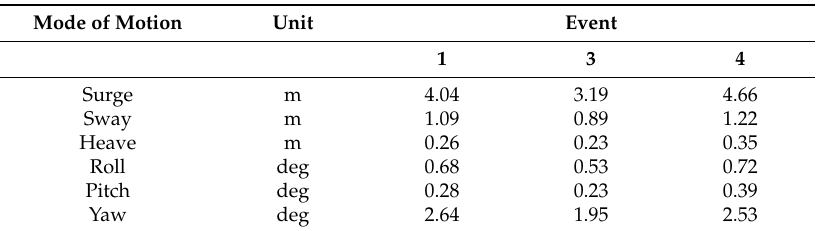
Table 4. Maximum peak-to-peak vessel motions for the Base Case.